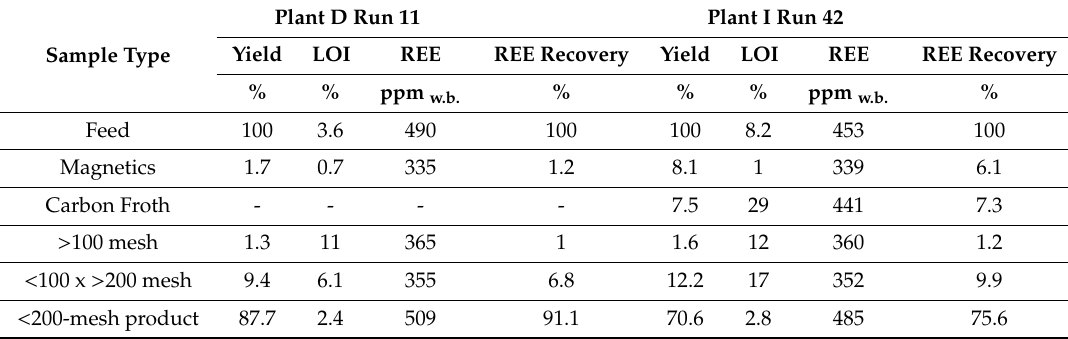
Figure 5. Particle size distribution for the plant D and I processed fly ashes. Table 1. Yield, loss-on-ignition (LOI), REE (ppm of lanthanides, Y, and Sc), and REE recovery (% of feed ash REE) for Run 11 / Plant D and Run 42 / Plant I. (“w.b.”—whole basis implies that the LOI is included in the calculation).